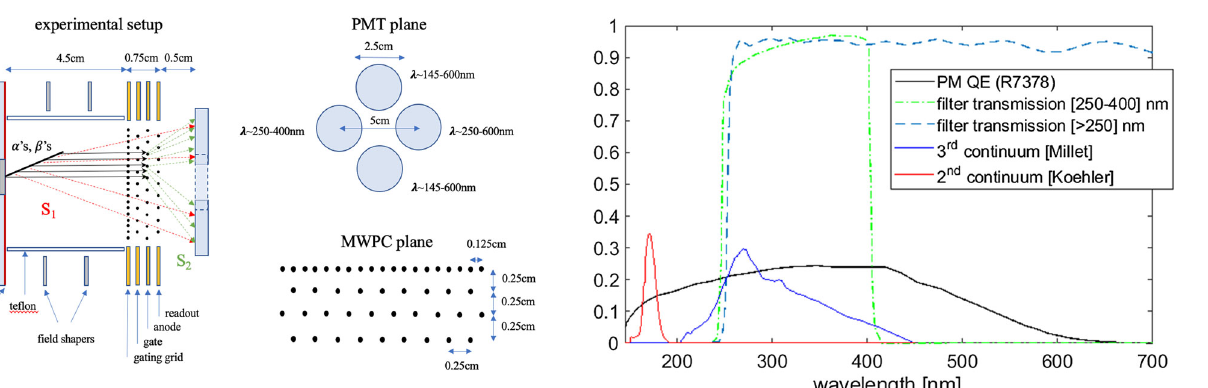
Fig. 3 Wavelength response of the filters and PM used in this work. The 2nd continuum spectra measured by Koehler [15] in an electron beam (red) as well as the 3rd continuum measured by Millet [22] at 1 bar (blue) are also shown, arbitrarily